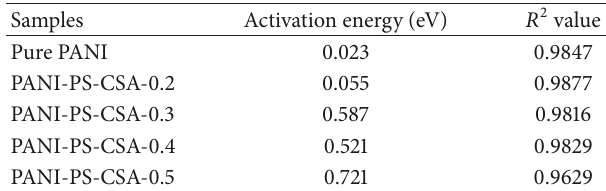
Table 1: Conduction activation energies for the pure PANI and PANI-PS blends containing various concentrations of